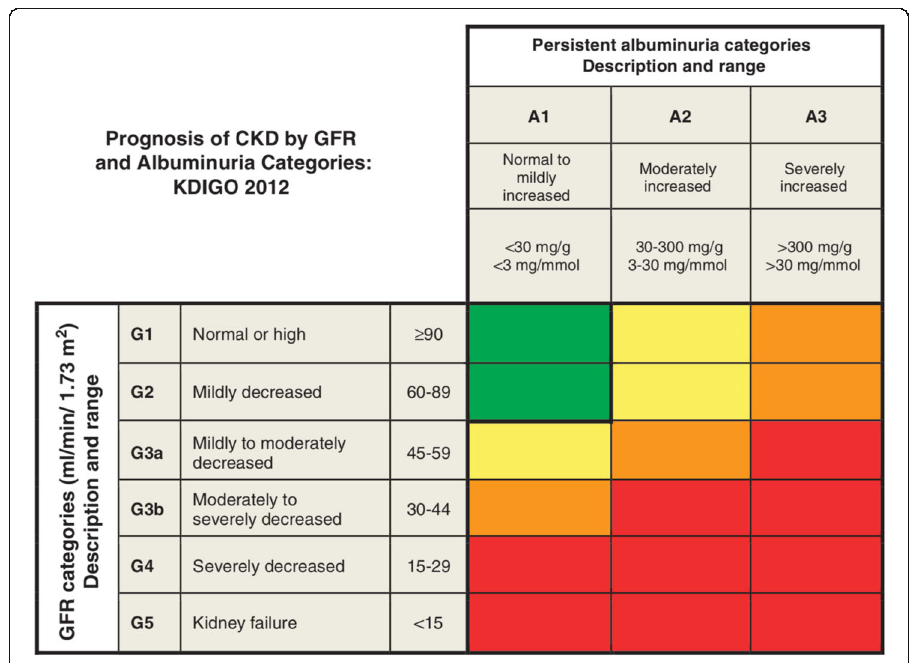
Fig. 1 Staging of CKD. Green: low risk (if no other markers of kidney disease, no CKD); yellow: moderately increased risk; orange: high risk; red: very high risk. From “ KDIGO 2012 Clinical Practice Guideline for the Evaluation and Management of Chronic Kidney Disease ” with kind permission by Kidney